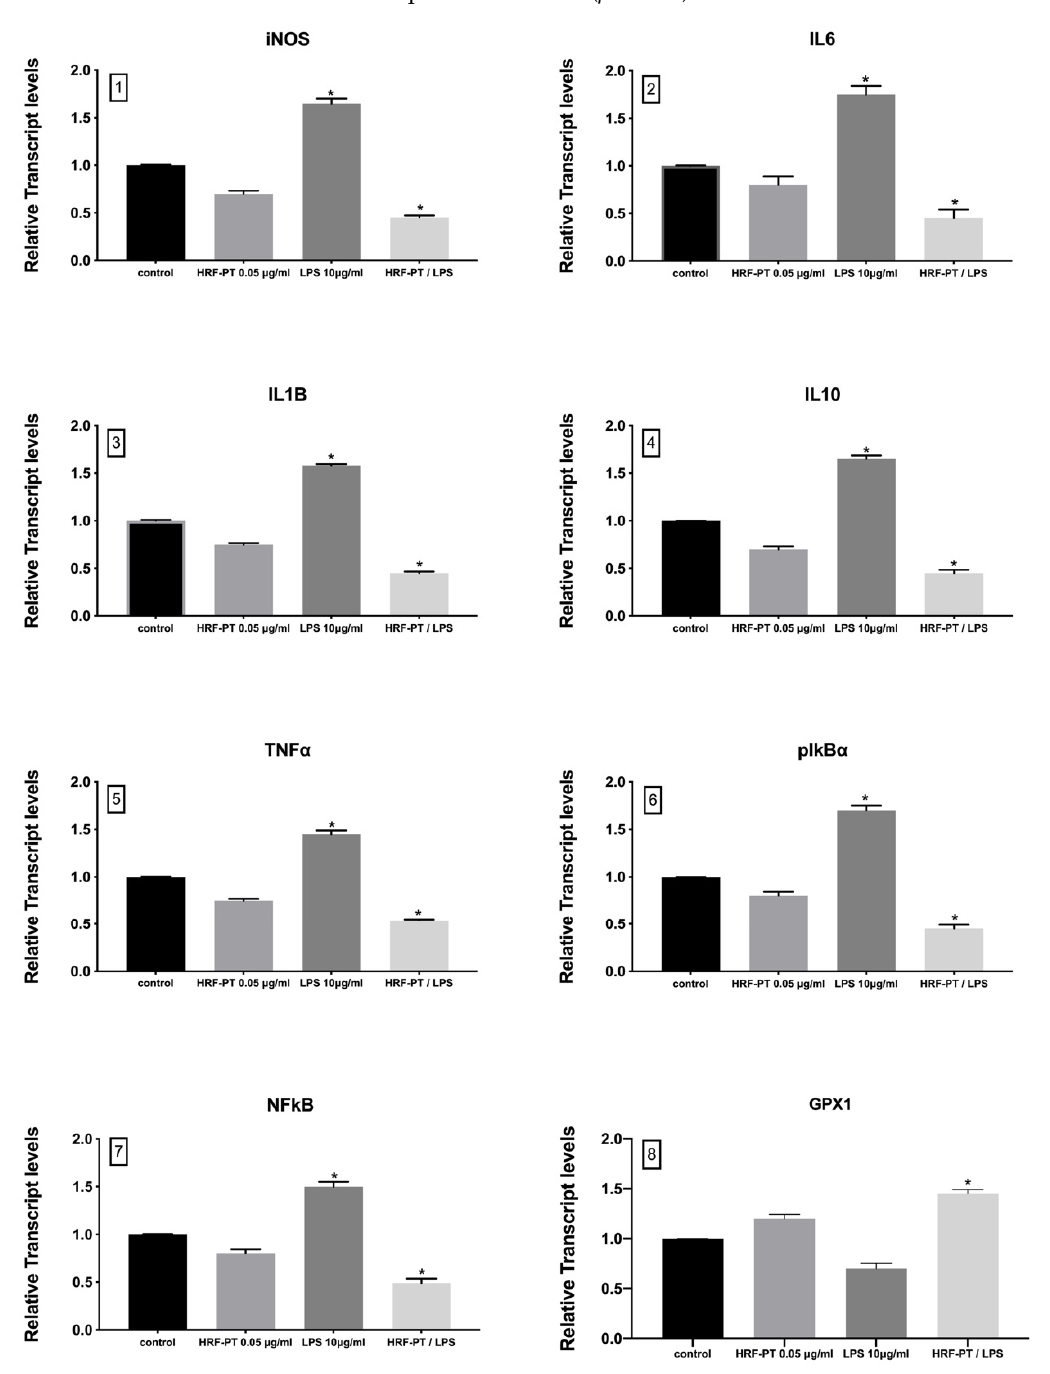
Figure 2. The relative gene expression of iNOS, IL6, IL1B, IL10, TNF α , pikB α , NFkB, GPX1 presented as a fold change ± SEM compared to untreated NHDF cells. The expressions of iNOS ( 1 ), IL6 ( 2 ), IL1b ( 3 ), IL10 ( 4 ), TNF α ( 5 ), pikB α ( 6 ), and NFkB ( 7 ) were down-regulated in NHDF cells with the addition of HRF-PT under or without LPS treatment compared to control ( p < 0.05). The expression of GPX1 ( 8 ), was up-regulated in NHDF cells with the addition of HRF-PT under LPS treatment compared to control ( p < 0.05). Experimental conditions: control (untreated NHDF cells), NHDF treated with HRF-PT (0.05 μ g/mL), LPS-treated NHDF (10 μ g/mL), LPS-treated NHDF (10 μ g/mL) with HRF-PT (0.05 μ g/mL). * p < 0.05 significantly different from the control (ANOVA test). The data correspond to the mean ± SEM of three independent experiments and six replicates each time.